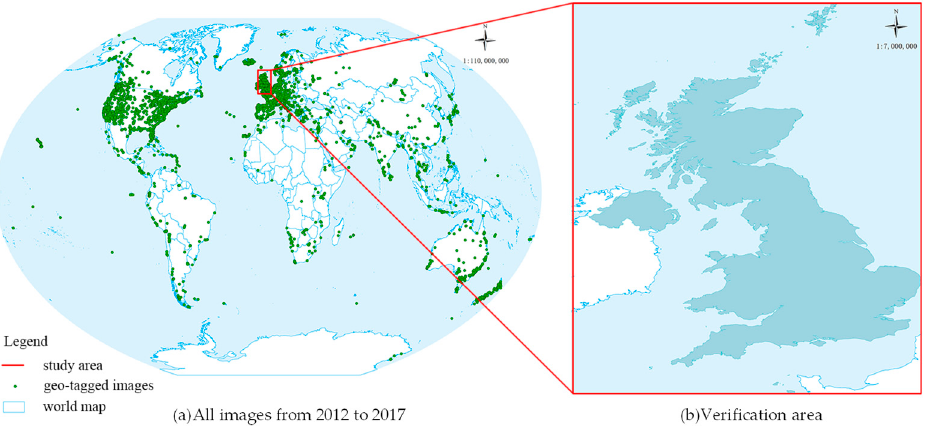
Figure 2. Spatial distribution of all geo-tagged natural scene images and verification area. ( a ) Spatial distribution of all geo-tagged natural scene images in dataset. ( b ) The verification area.